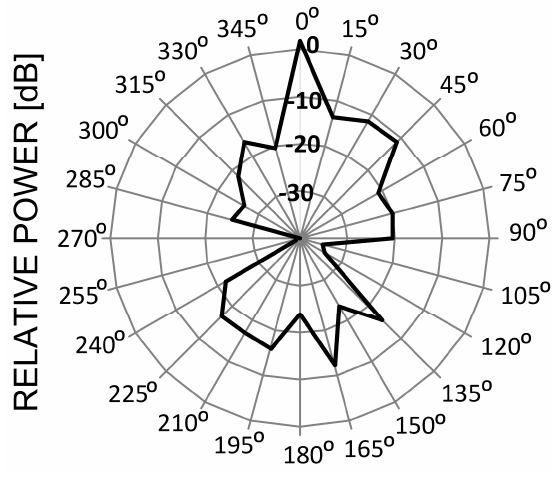
Figure 9. Radiation pattern of the microwave oven [16].